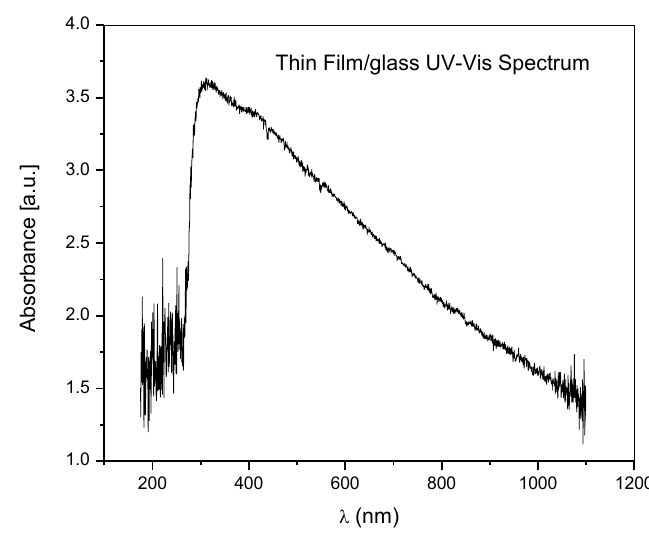
Figure 7. UV-VIS spectra of deposited thin film on glass.